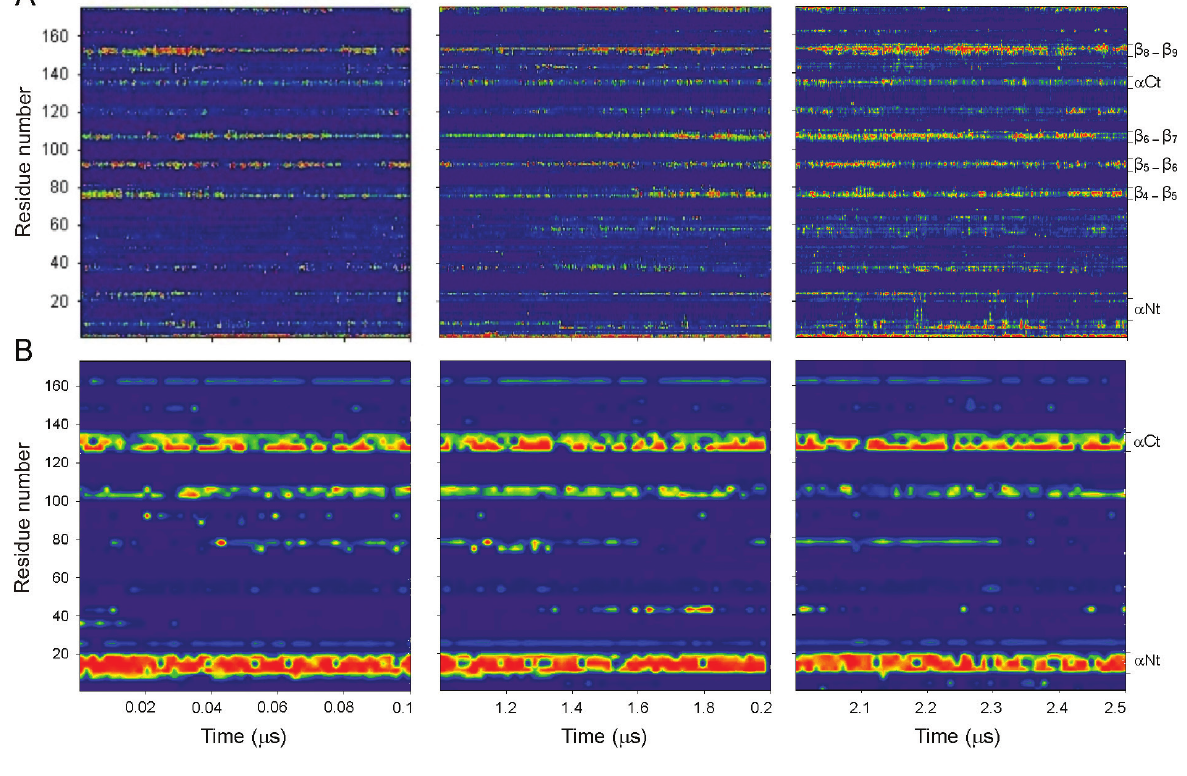
Figure 6 - (A) All-atom root mean square fluctuation (RMSF) from 0.06 to 0.14 nm for EqtxII in acidic solution (System 2) over the 0.25 μs simulation as a function of both time and residue numbers are presented together with its corresponding (B) ellipticity from 0 to 80 % at 222 nm (percentage of time in which the residues present a helical nature). Both analyses range from blue to red according with the increase in flexibility or helical